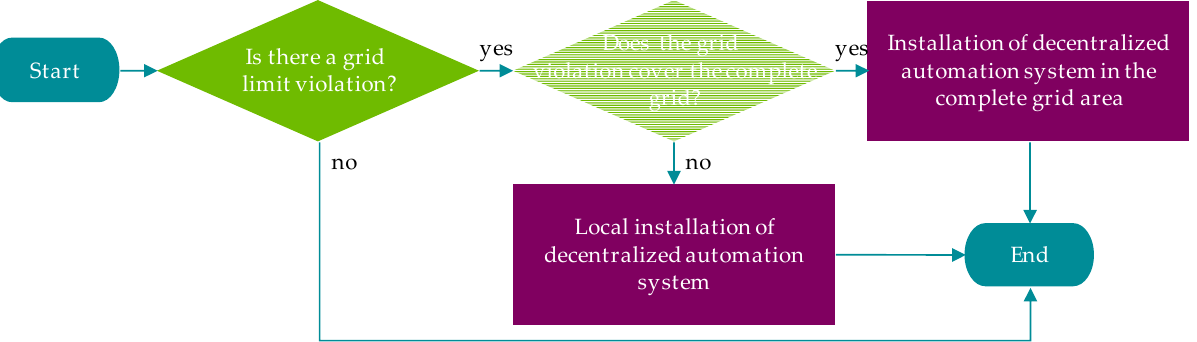
Figure 5. Flowchart for the installation of the components of the decentralized automation system for applying load management based on [59].